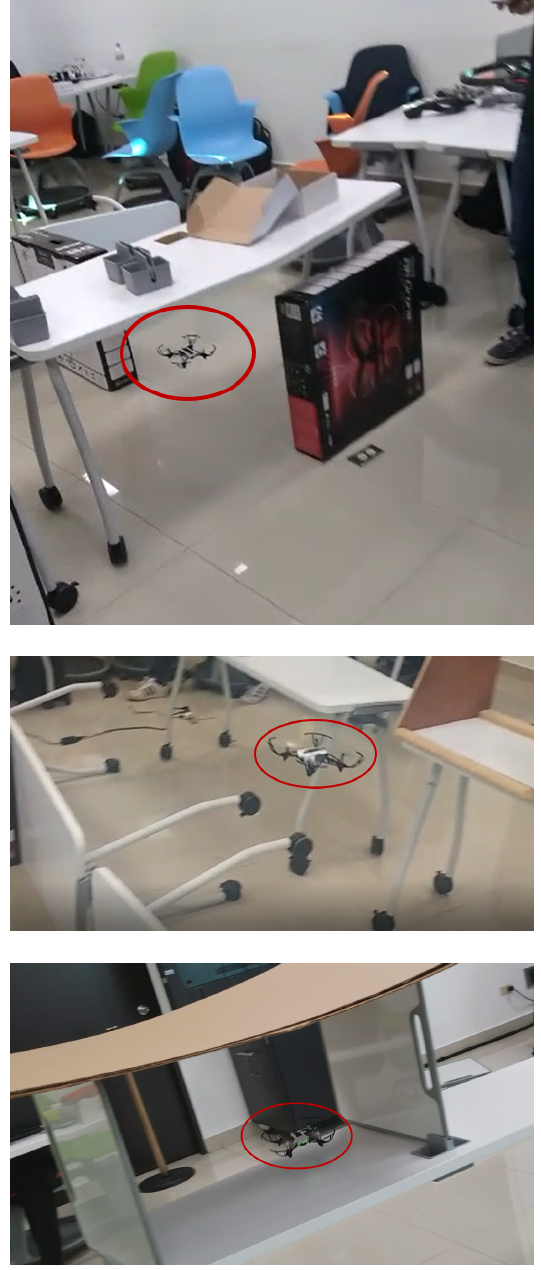
Figure 3. MAMBO drone attempts on the test track (final